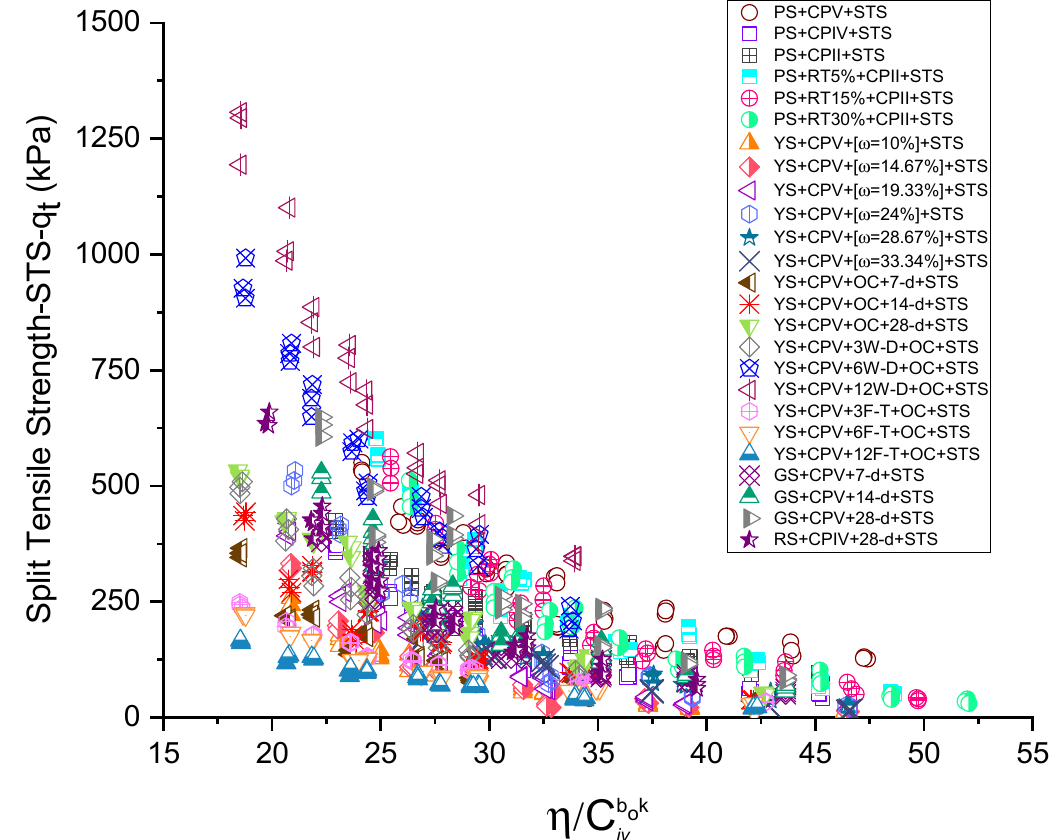
Figure 6. Influence of porosity/volumetric cement index, adjusted at b o = 0.174 and k = 2.565, on split tensile strength for several types of sedimentary silts stabilized with distinct cements and molded in several conditions of moisture using various curing times.